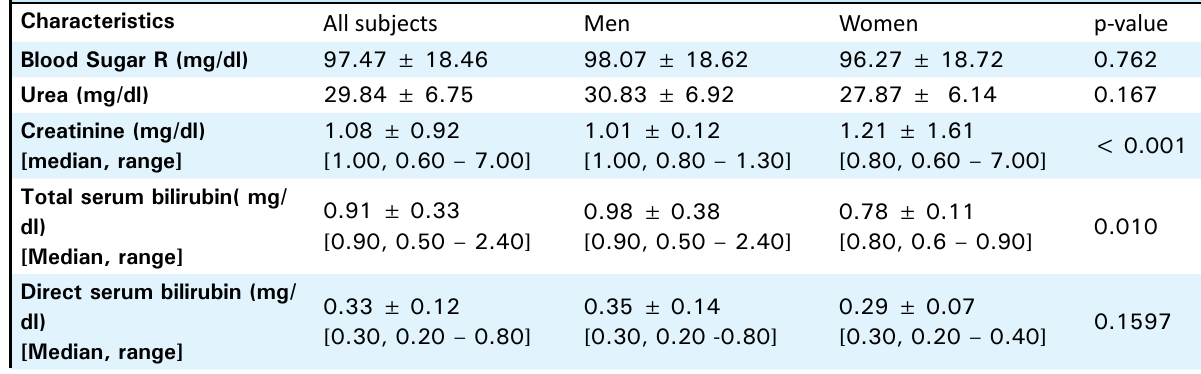
table 2. Laboratory parameters of the study